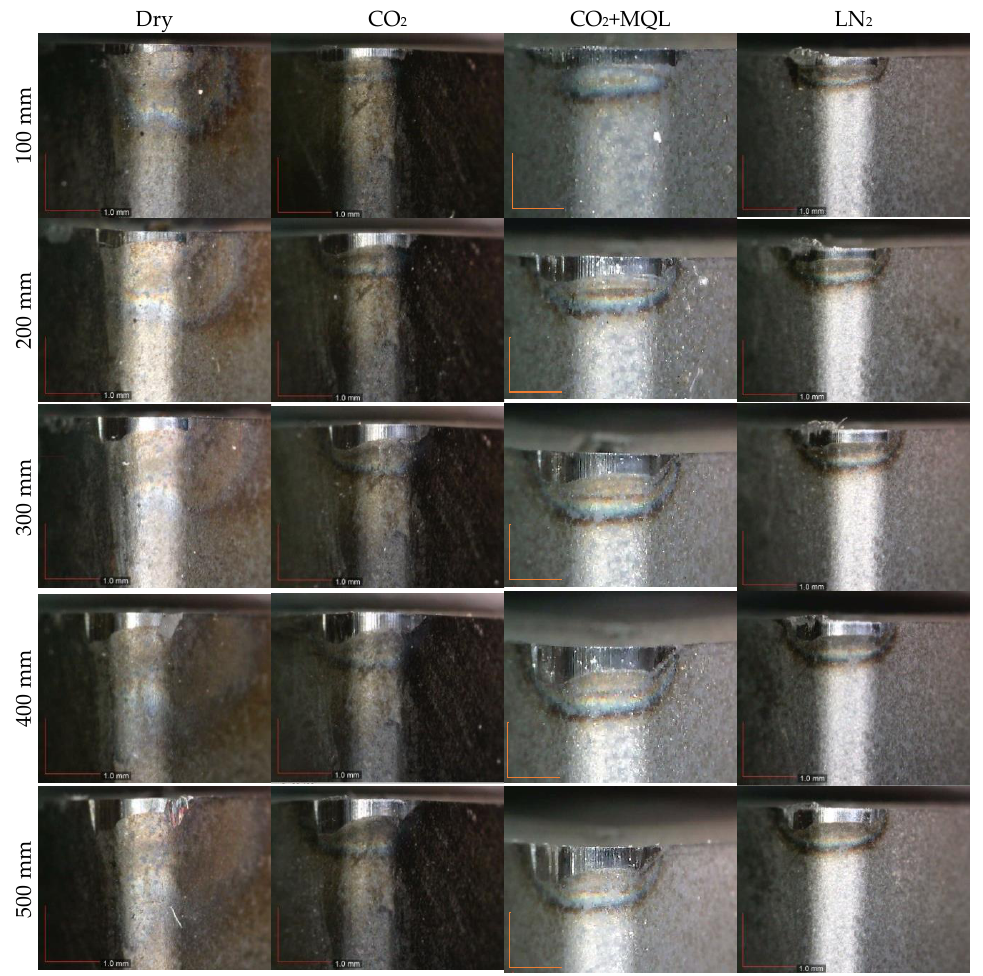
Figure 5. Images of progressive nose wear under various machining conditions.